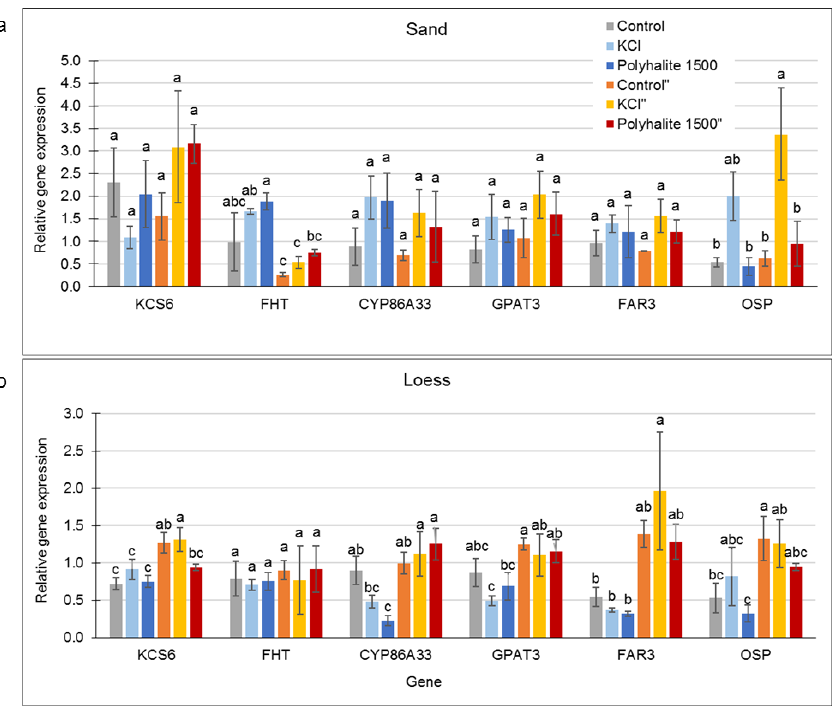
Figure 4. Expression of suberin-related genes KCS6 , FHT , CYP86A33, GPAT3 , and FAR3 , and skin-set-related gene OSP , in skin of sweet potato storage roots (SRs) grown in sandy ( a ) and loess ( b ) soil types, and treated with a preplanting application of the fertilizers KCl at 350 kg ha − 1 , or polyhalite at 750 or 1500 kg ha − 1 . SRs were collected at around 100 days after planting (DAP) (blue–gray bars) and at harvest, 150 DAP (yellow–red bars, marked with inverted commas in the color key). Transcript levels were monitored by qPCR and expression levels were normalized relative to that of the reference gene PLD . Values are averages of three replicates with SE. Data were analyzed for statistical significance among means by Student’s t -test; different letters indicate significantly different values ( p < 0.05).